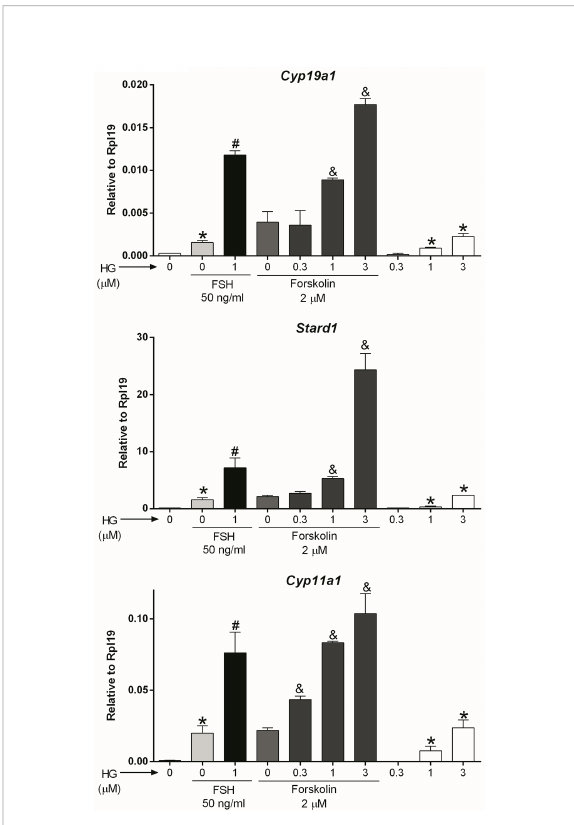
FIGURE 2 SIK inhibition enhances forskolin actions. Rat GCs were pretreated with vehicle or 0.3, 1, or 3 µM of HG for one hour; then, cells were treated with vehicle, FSH, or forskolin (an adenylate cyclase activator). Cyp19a1 , Stard1 , and Cyp11a1 mRNA levels were determined 48 h after adding FSH or forskolin. One-way